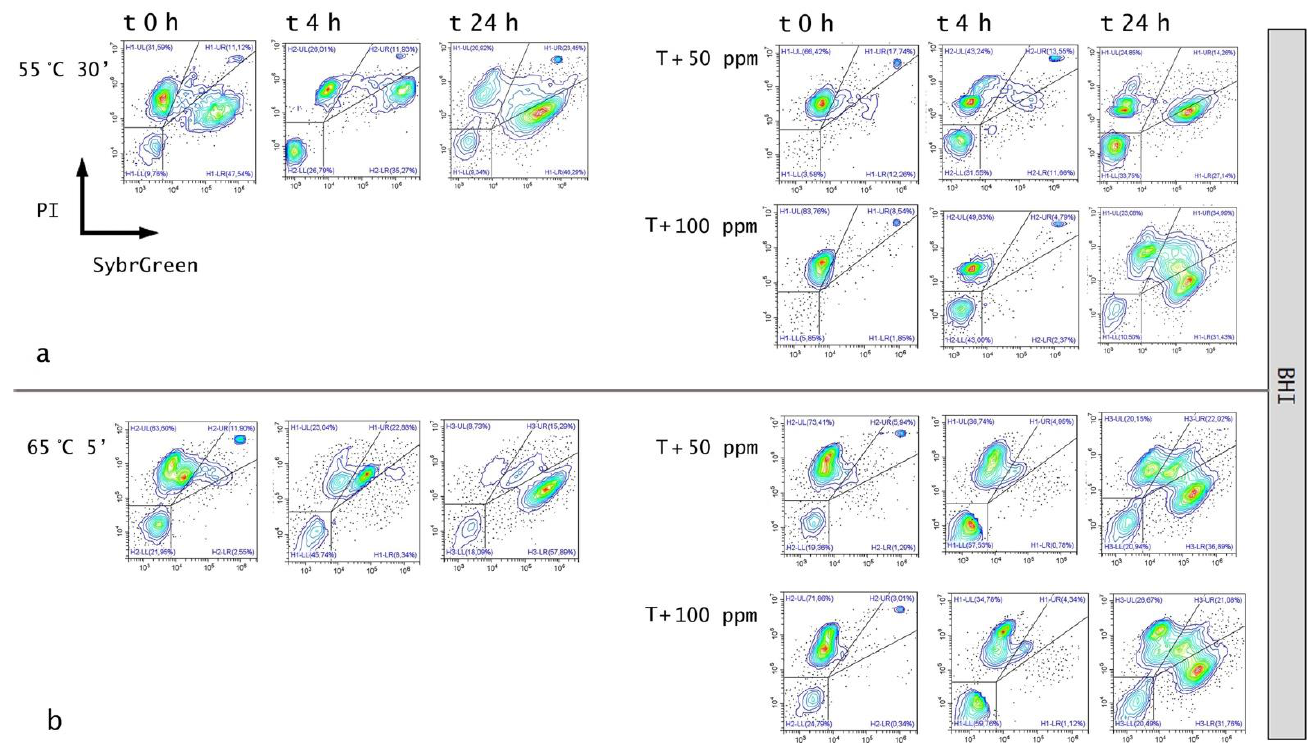
Figure 5. E. coli cell load in Brain Heart Infusion medium and plated on MacConkey agar (Log CFU/mL). Thermal treatment (55 °C 30 min) alone and combined with OEO (50 and 100 ppm); thermal treatment (65 °C 5 min) alone and combined with OEO (50 and 100 ppm).